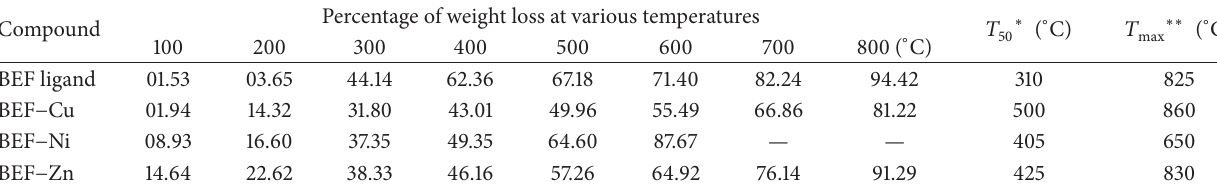
Table 4: TGA data for thermal stability.